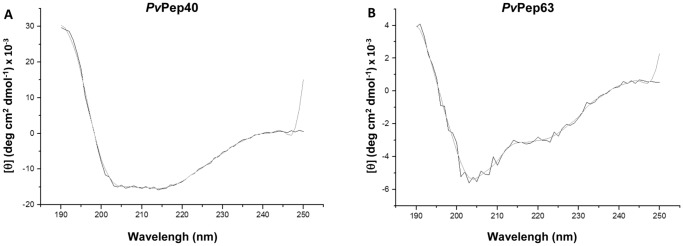
Representative CD spectra of peptides (A) PvPep40 and (B) PvPep63.The CD's were done at room temperature on 150 µg/mL samples in aqueous solutions. Spectrums came from the averages of duplicates in the far UVs, from 190 to 250 nm and were smoothed with a 5 points filter.